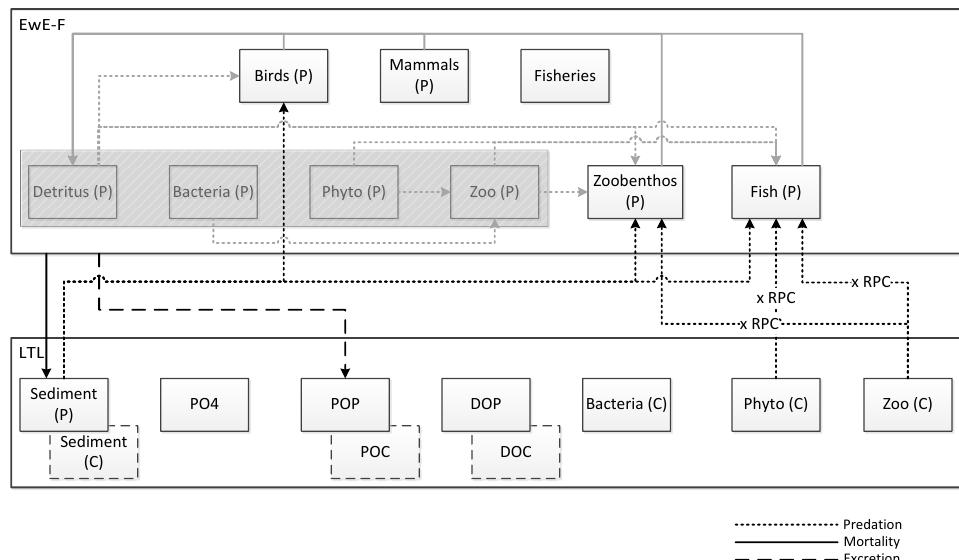
Figure 4. Coupled trophodynamic model scheme of the Gulf of Trieste (northern Adriatic Sea) showing the linkages between the HTL and LTL models. Phosphorus (denoted with P) was used as the currency for all of the HTL state variables and flows linking the two models. Flows originating from the state variables of the LTL model to the HTL model, which were expressed in carbon (denoted with C), i.e. phytoplankton and zooplankton, were converted to phosphorus (by multiplying variable-specific phosphorus-to-carbon (RPC) ratios) before being transferred. Grey-shaded state variables and flows in the HTL model were replaced by the LTL model’s corresponding state variables and the new linked flows are shown in black dashed and continuous lines. Abbreviations: Zoo (small and large zooplankton groups), Phyto (small and large phytoplankton groups), PO 4 (phosphate), POP (particulate organic phosphorus), and DOP (dissolved organic